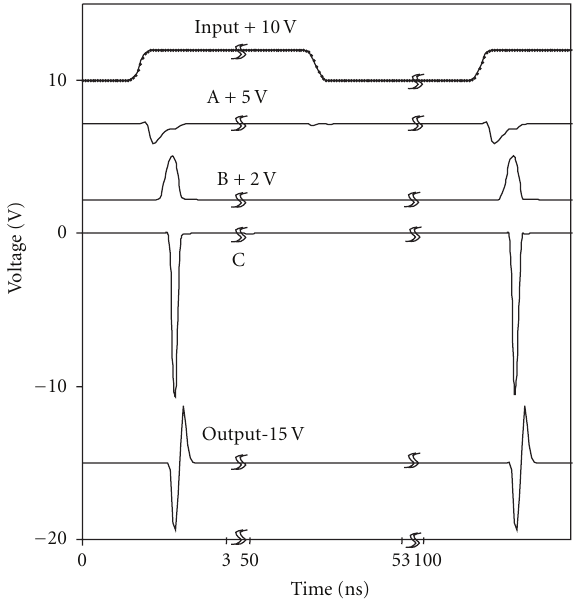
Figure 5: Simulated voltage waveforms at the input and output of the pulse generator as well as the internal nodes A, B, and C labeled in Figure 4. The negative pulse generated from the rising edge of the input signal is progressively amplified and shaped, while the positive pulse generated from the falling edge of the input signal is barely discernable at A and is completely suppressed at the output. Artificial o ff set voltages are added for